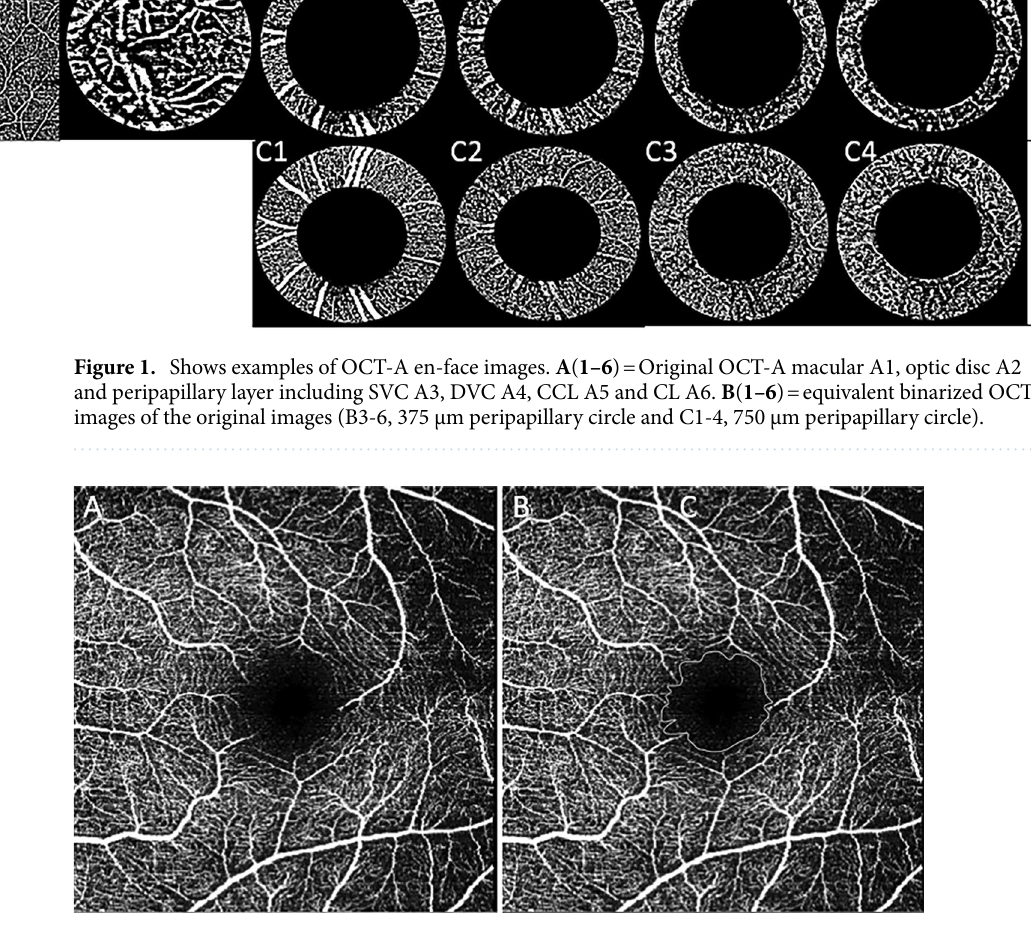
Figure 1 offers a visualization of a complete set of OCT-A images per patient per examination date.